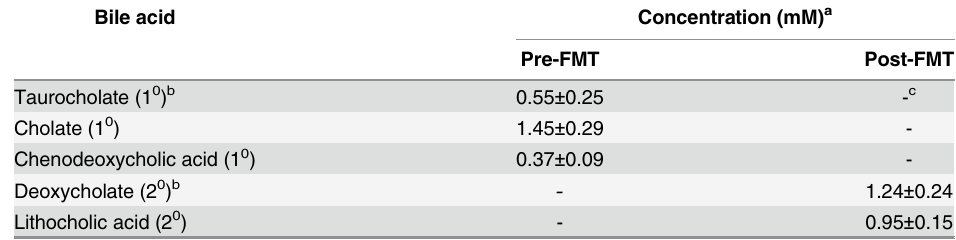
Table 1. Average concentration of bile acids measured in patient feces before and after FMT and con- centration used in bile acid combinations. Bile